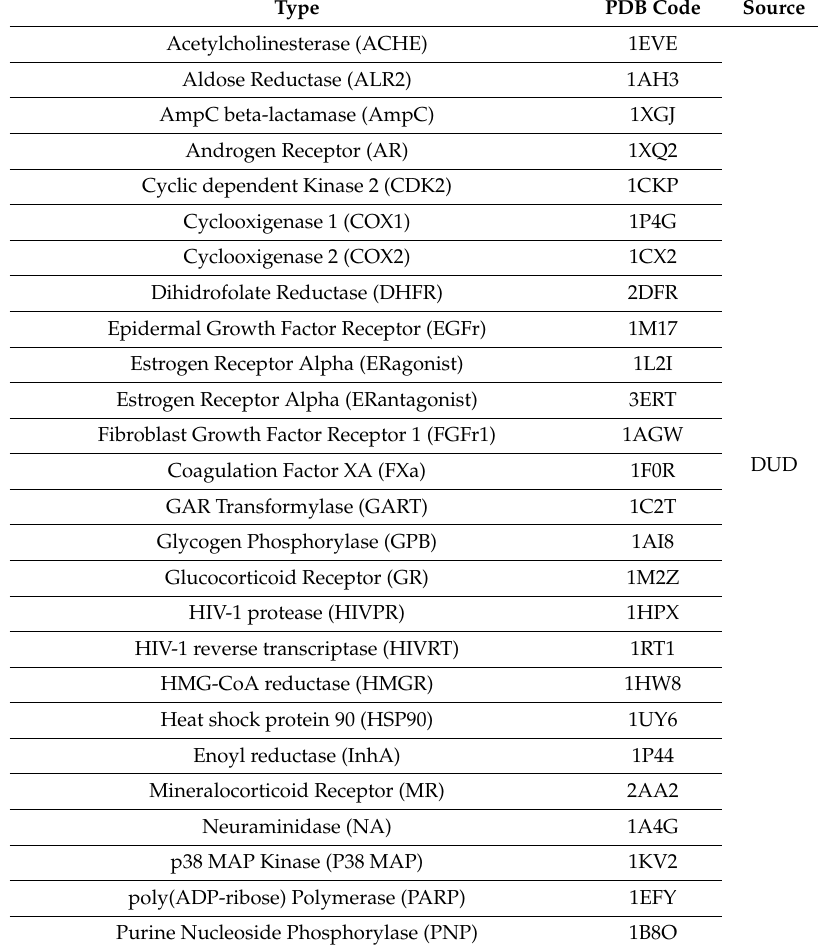
Table 1. A list of the 60 targets selected from the DUD, MUV, and ChEMBL datasets. The typology and PDB code [18] of each target are listed in the